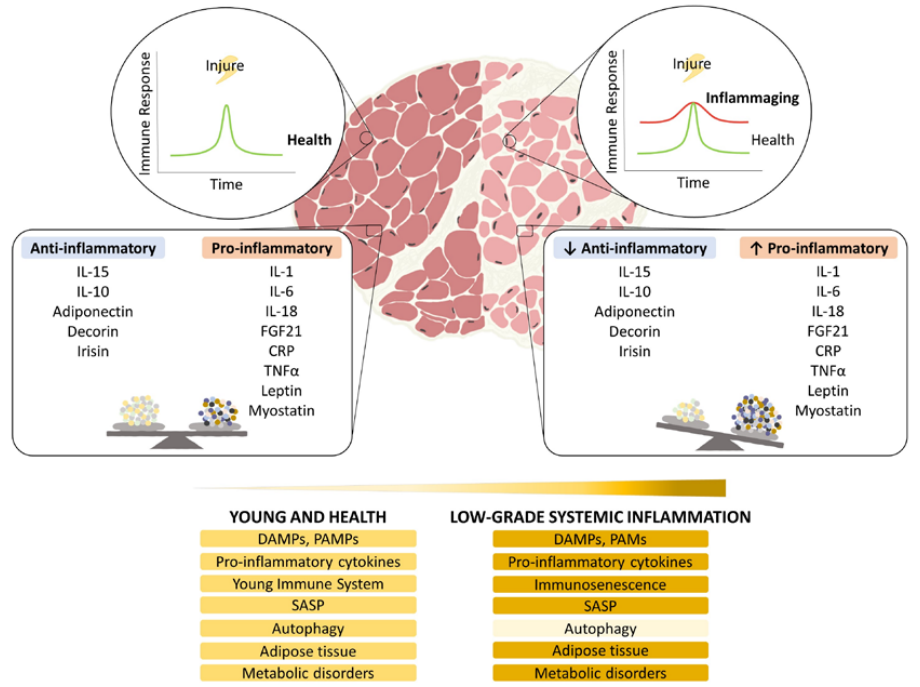
Figure 1. Overview of the main factors affecting aging associated inflammation in